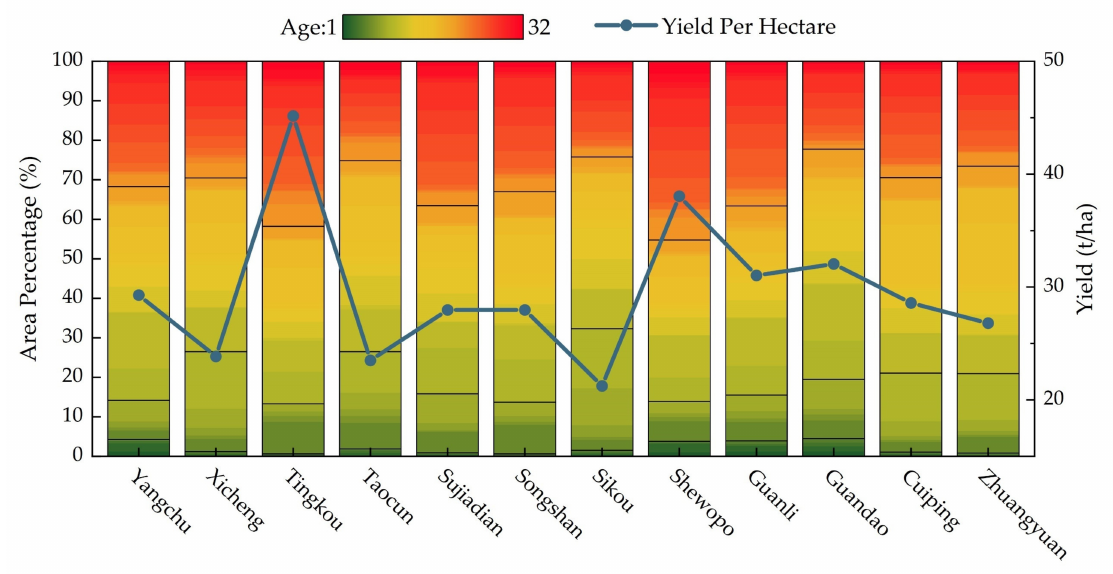
Figure 10. The comparison of orchard planting age structure and regional orchard